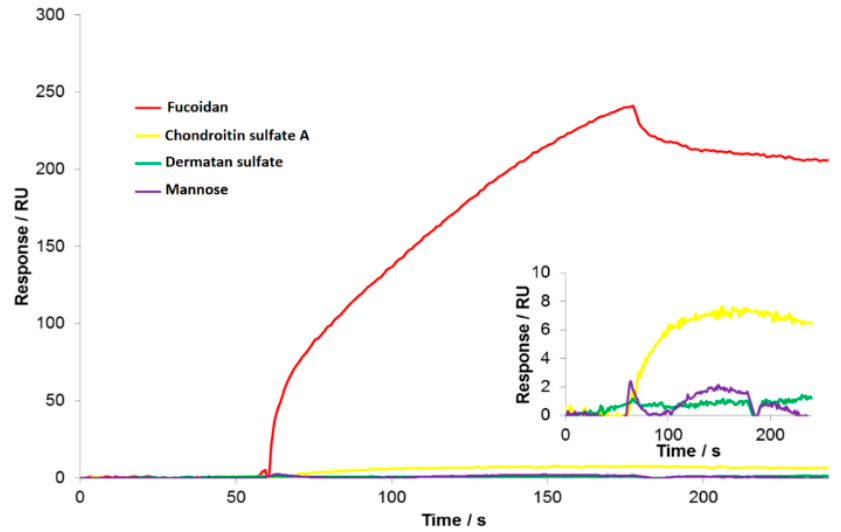
Figure 1. SPR sensorgrams displaying the binding of the glycosaminoglycans (GAGs), at 1 μ M with His-tagged Lcl proteins immobilized on the NTA-modified gold sensor chip surface. Other conditions were as described in the Experimental section.